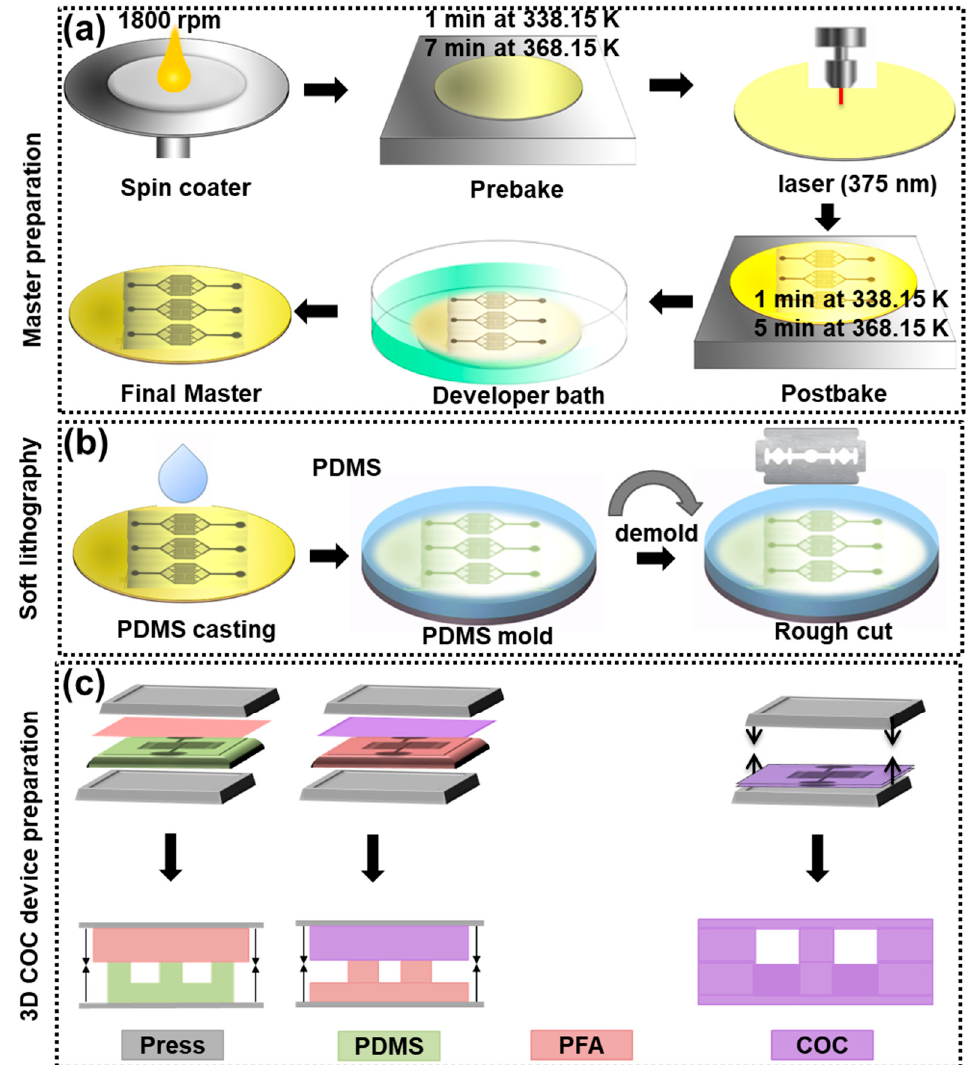
Figure 1. Combination of soft lithography and hot-embossing techniques for COC microfluidic device fabrication. ( a ) The photolithographic master fabrication involves spin coating, baking, and engraving with a laser writer. ( b ) After development, the uncured photoresist is removed and the resulting microchannel is replicated using polydimethylsiloxane. ( c ) The replica is peeled off the master device, which is used as the template for the PFA-intermediate stamp, which transfers the structure onto the COC.